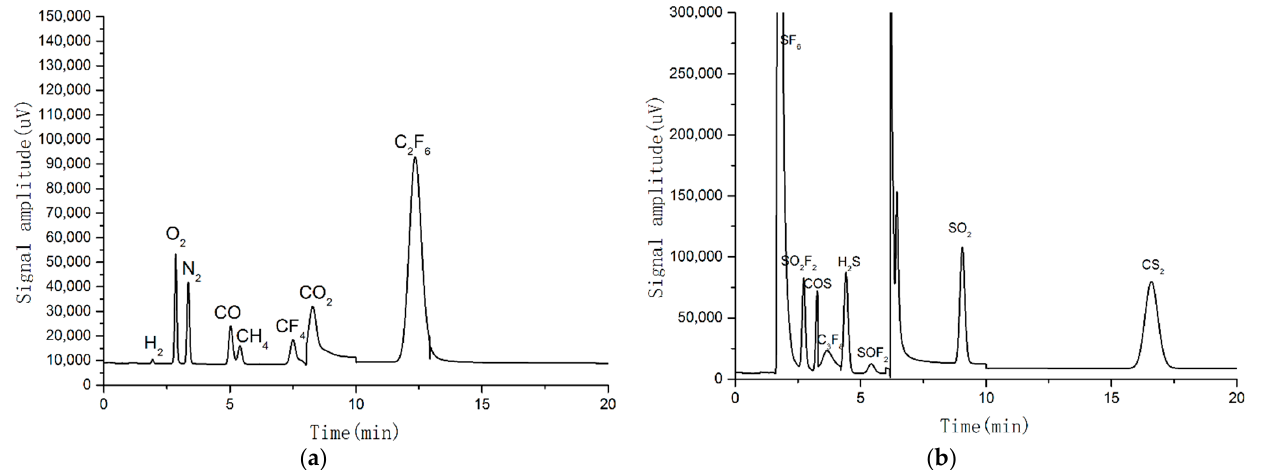
Figure 2. Gas chromatograph test result. ( a ) Channel A. ( b ) Channel B. Table 1. Setting of breaking experiment with different H 2 O concentration.